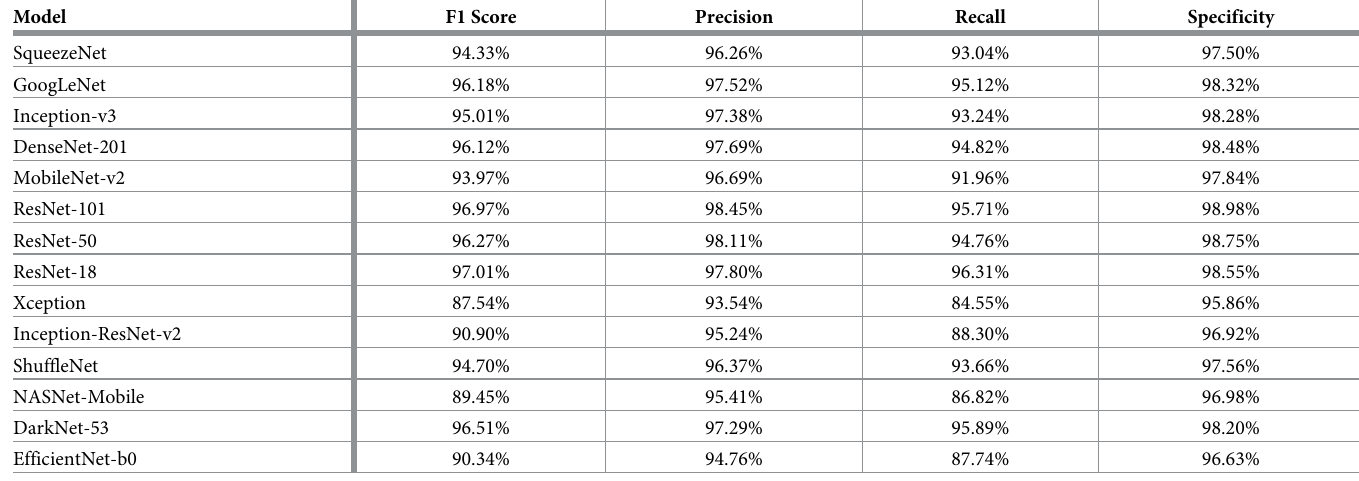
Table 4. The mean overall F1 score, precision, and recall parameters for the 14 deep learning models performing normal vs scoliosis classification.